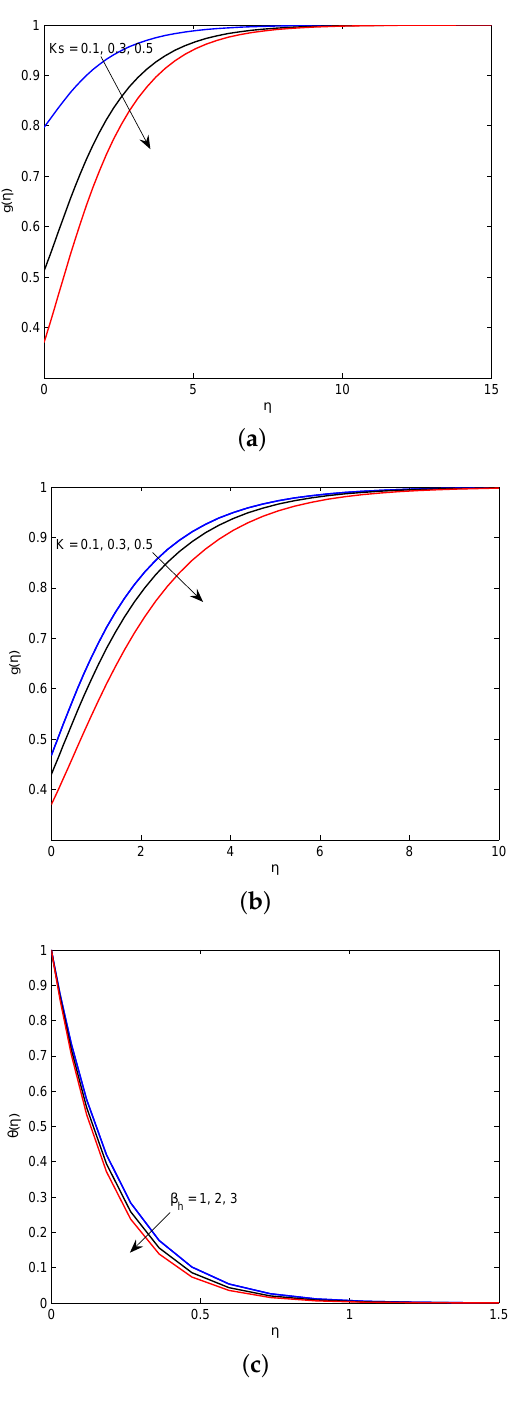
Figure 5. Variations in g with respect to ( a ) K s and ( b ) K , and in ( c ) θ with respect to β h when φ = 0.1, M = 2, and Pr =